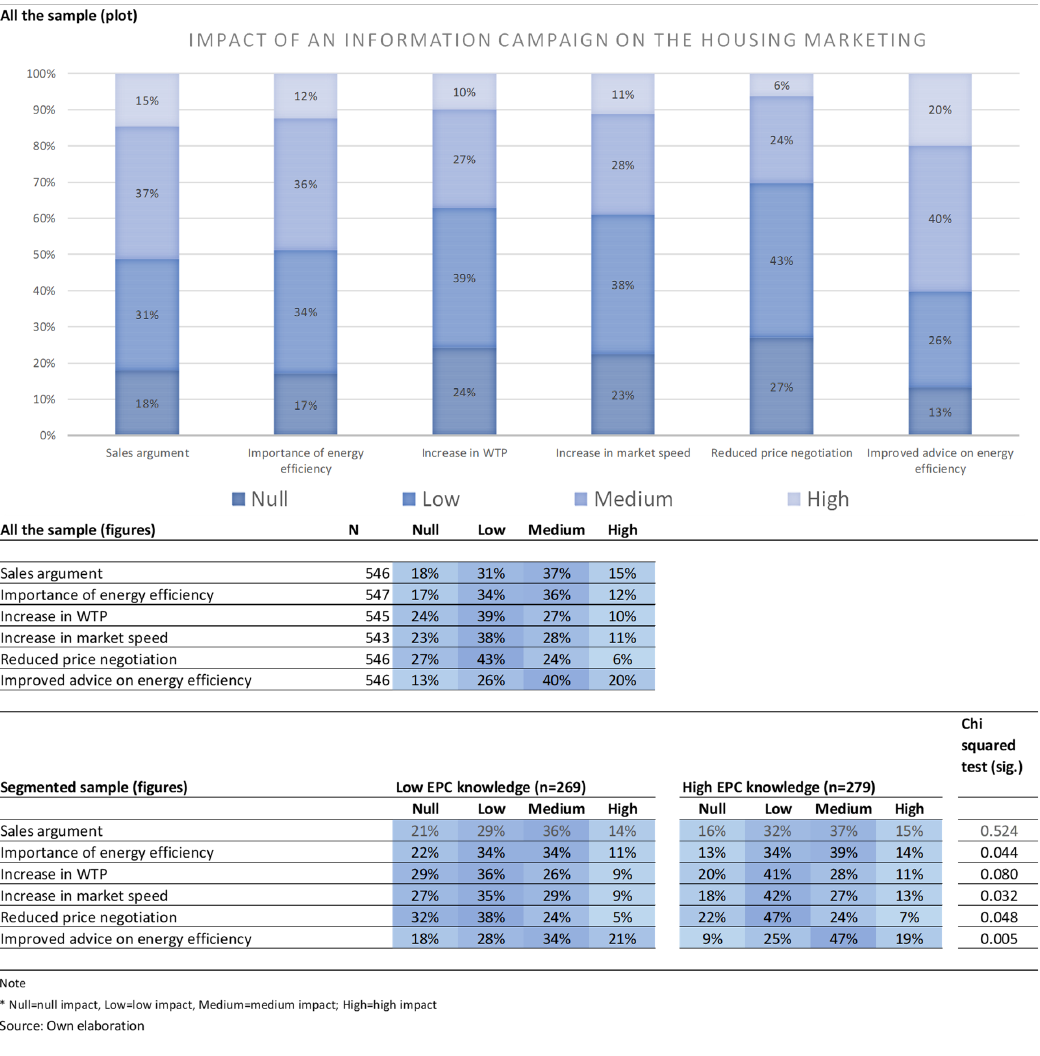
Figure 6. Perceived potential impact of an EPC information campaign.